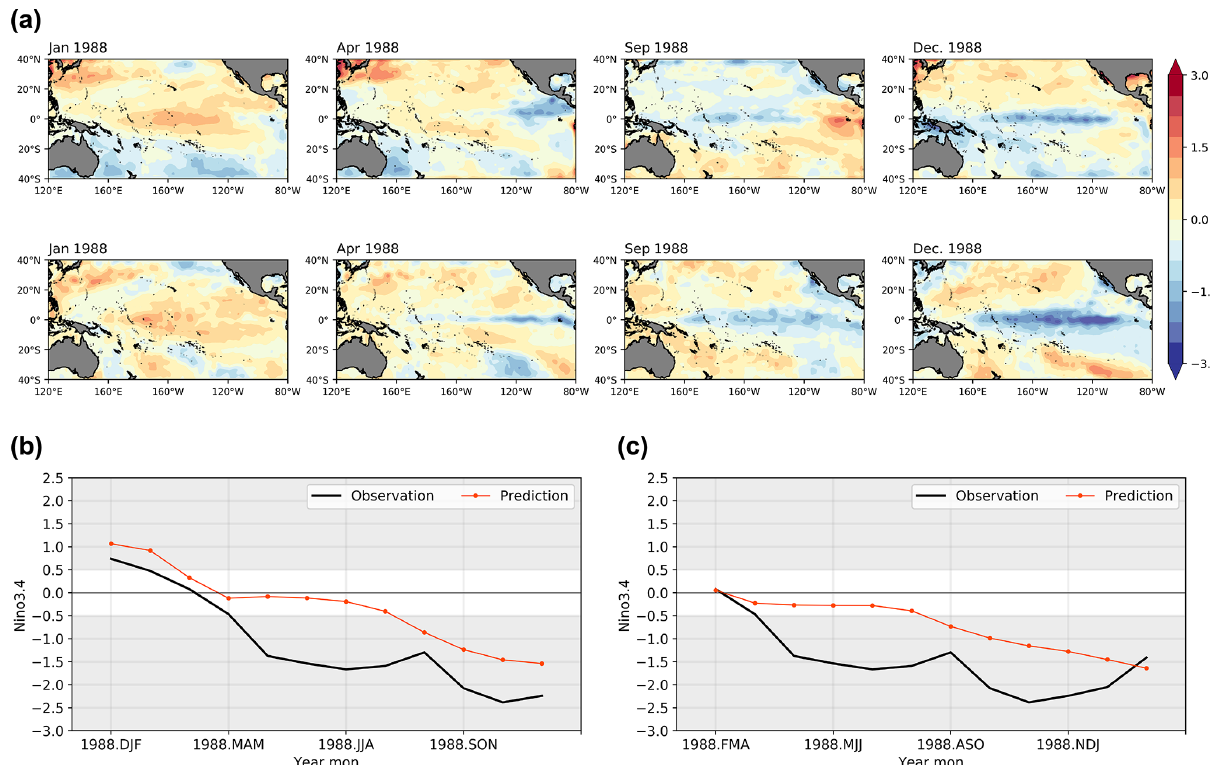
Figure 8. The SST anomalies patterns and index prediction results for 1988–1989 La Niña using ENSO-MC. (a) Spatial development of SST anomalies predicted (the first row) 1 year in advance compared with the real observations (the second row) for the transition, onset, growth and mature phases. (b) Niño 3.4 index time series forecast initiated in the DJF season using ENSO-MC (red line) and the observed Niño 3.4 index (black line). (c) Niño 3.4 index time series forecast initiated in the FMA season using ENSO-MC (red line) and the observed Niño 3.4 index (black